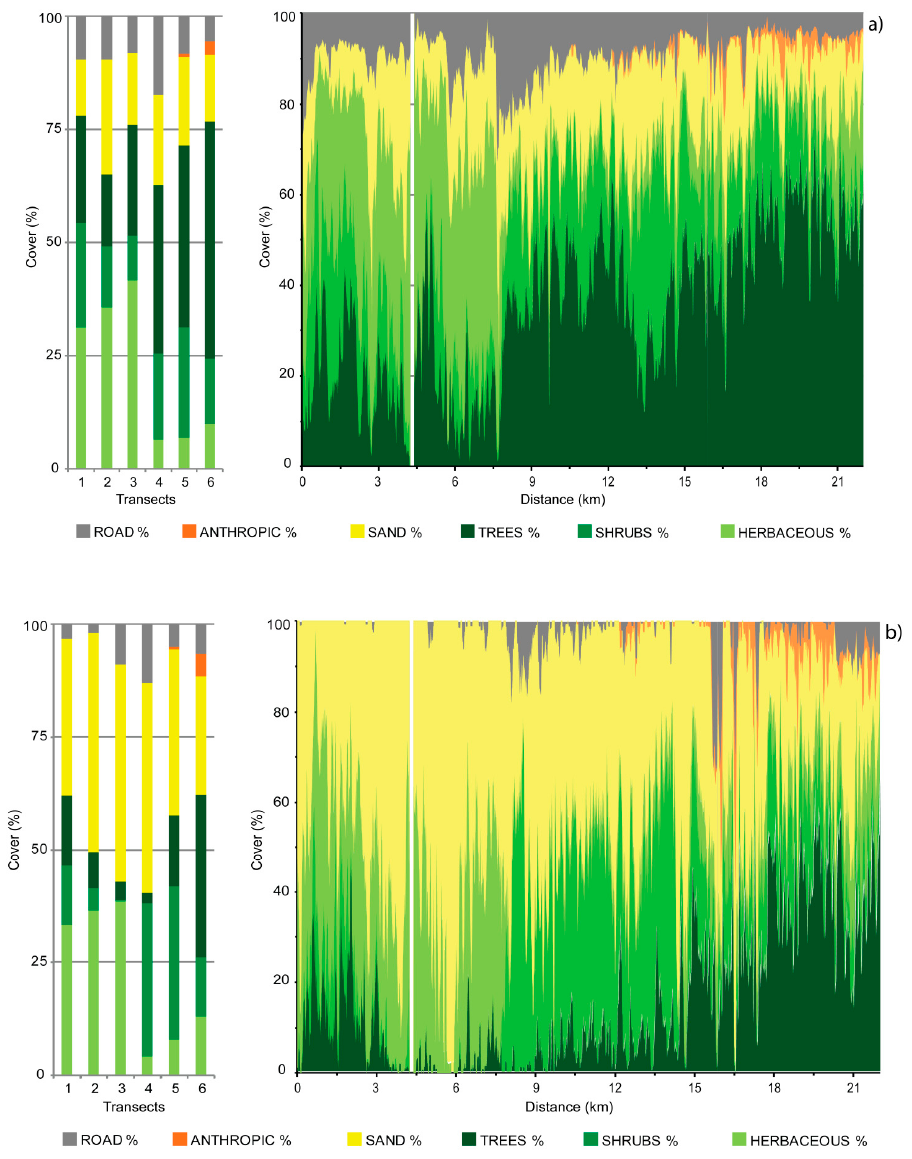
Figure 8. Cover typology abundance in six transects (left side) and along the stretch (right side) for ( a ) the dune and ( b ) the foredune.